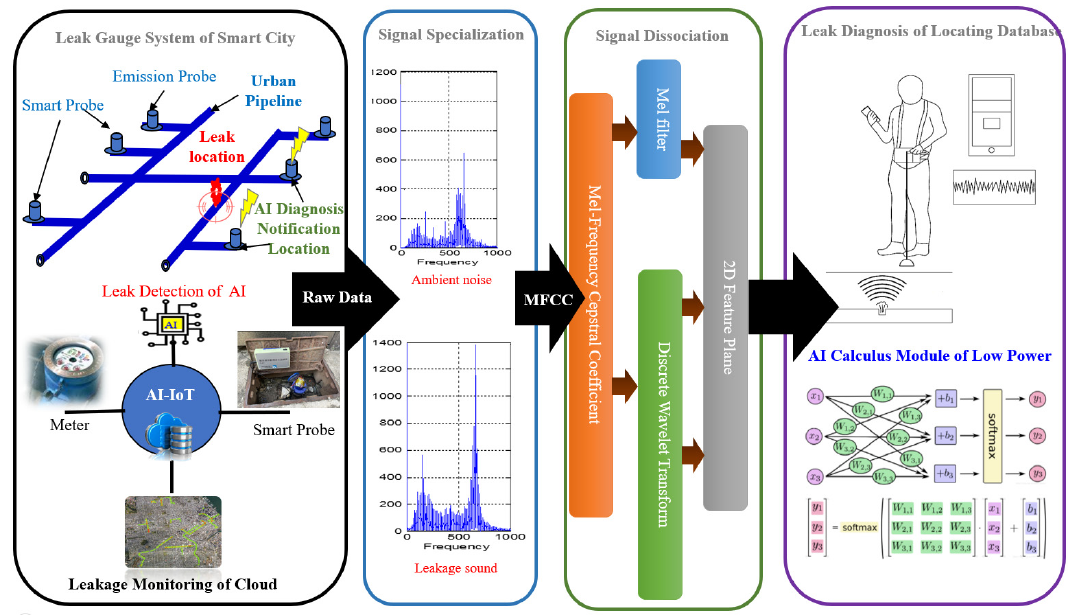
Figure 1. AI-IoT-Based AI Leakage Detection and Localization